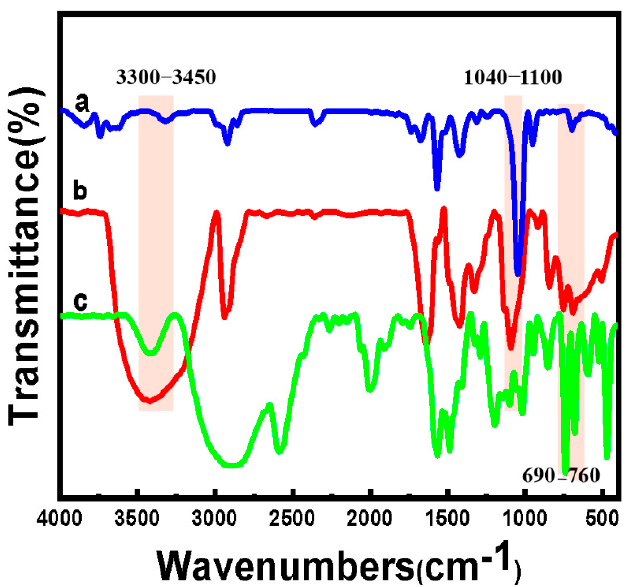
Figure 1. FTIR spectra of ( a ) etherified PVA, ( b ) N-alkylated product, and ( c ) PVA-g-PANI.